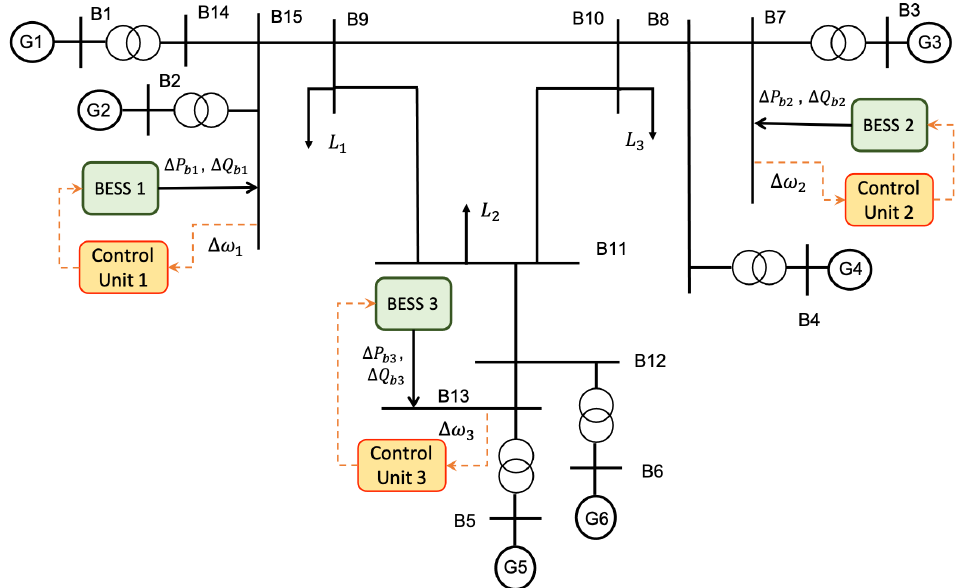
Figure 1. Three-area power system case study